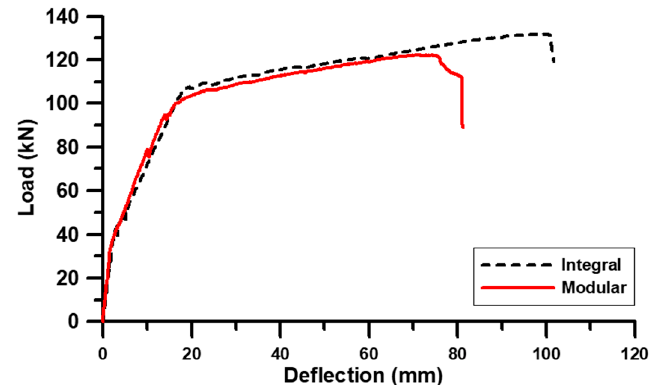
Table 2. Results of the static loading test for the integral and modular specimens.